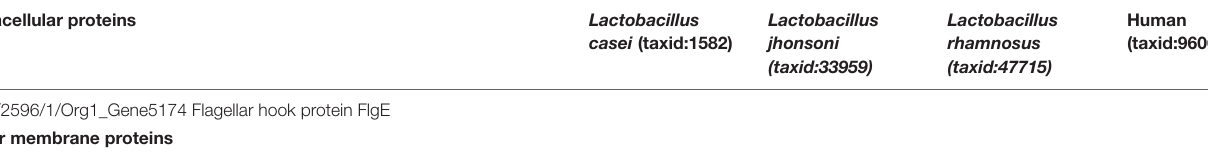
TABLE 4 | Homology check of proteins against probiotic bacteria and human proteome. Extracellular proteins